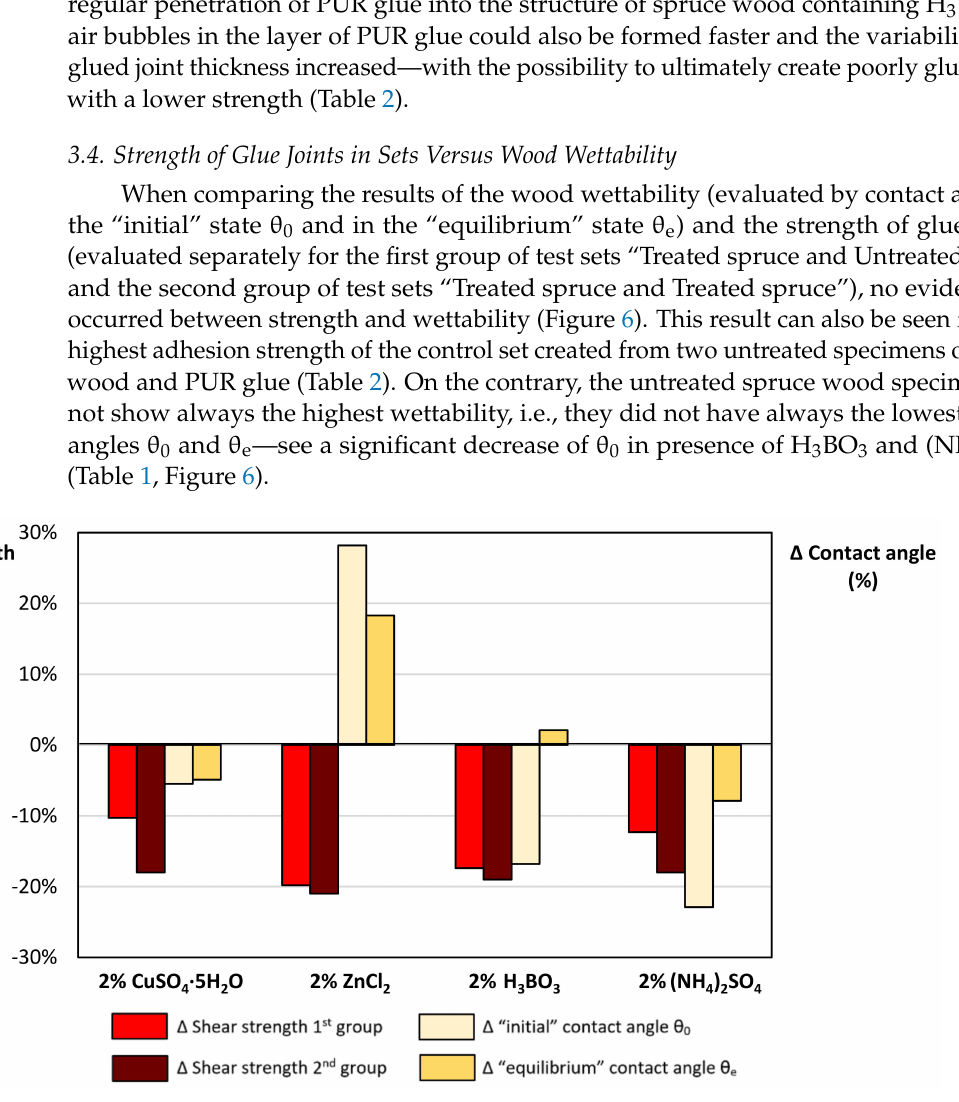
Figure 6. Comparison of the percentage change in the strength of glued joints ( ∆ σ ) for the first and second group of test sets and the percentage changes in the contact angles ( ∆ ◦ ) for the spruce wood specimens treated with the 2% solutions of inorganic